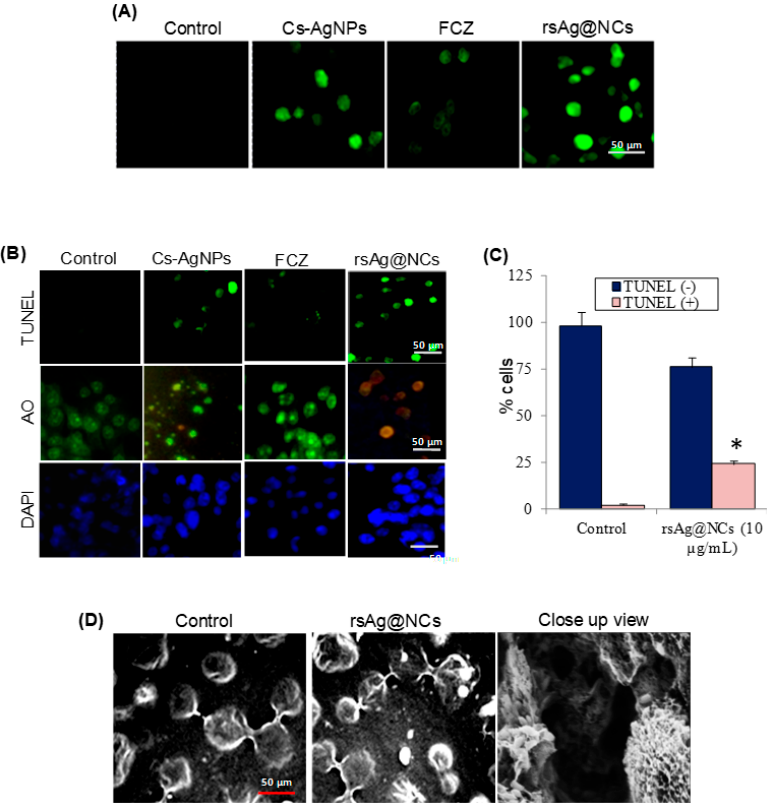
Figure 3. The rsAg@NCs accelerate the induction of apoptosis in FCZ-resistant C. albicans NBC099. ( A ) Immunofluorescence detection of apoptosis using the M30 CytoDEATH antibody that binds to the caspase-cleaved epitope of the cytokeratin 18 cytoskeletal protein, a marker of apoptosis. Cells were exposed to Cs-AgNPs (10 µg/mL), FCZ (60 µg/mL), and rsAg@NCs (10 µg/mL). After 24 hr of incubation, cells were incubated with M30 CytoDEATH antibody. A marked increase in M30 fluorescence was observed by a fluorescence microscope. ( B ) Cells were treated with Cs-AgNPs (10 µg/mL), FCZ (60 µg/mL), and rsAg@NCs (10 µg/mL) for 24 hr at 37 °C for further assessment of apoptosis using terminal deoxynucleotidyl transferase dUTP nick end labeling (TUNEL), acridine orange (AO), and 4 ′ ,6-diamidino-2-phenylindole (DAPI) staining assays. For the TUNEL assay, cells were washed in PBS, permeabilized for 2 min on ice and washed again with PBS. DNA ends of cells were labelled by using the APO BrdU TUNEL Assay Kit, and cells were observed under a fluorescence microscope. The permeabilized cells were stained with 5 µg/mL and 1 µg/mL of AO and DAPI, respectively. Subsequently, cells were used to detect apoptosis by using a fluorescence microscope. ( C ) The percentage of TUNEL (-) and TUNEL (+) cells due to the treatment of 10 µg/mL rsAg@NCs. Each reported value represents the mean ± SE from three independent experiments (* p < 0.001, compared with the untreated control). ( D ) Cells were treated with 10 µg/mL rsAg@NCs for 24 hr, washed, and fixed overnight in 2.5% glutaraldehyde in phosphate magnesium buffer. Again, cells were post-fixed for 2 hr in 2% osmium tetroxide. The washed cells were stained with 1% aqueous solution of uranyl acetate for 30 min. After two further items of washing, cells were dehydrated in 95% and 100% ethanol, subsequently. Cells were polymerized in 1:1 propylene epoxy embedding material (Epon) mixture, and then overnight in fresh Epon for 45 hr at 65 °C. Ultra-thin sections of the cells were stained with uranyl acetate and lead citrate and examined by scanning electron microscopy (SEM).